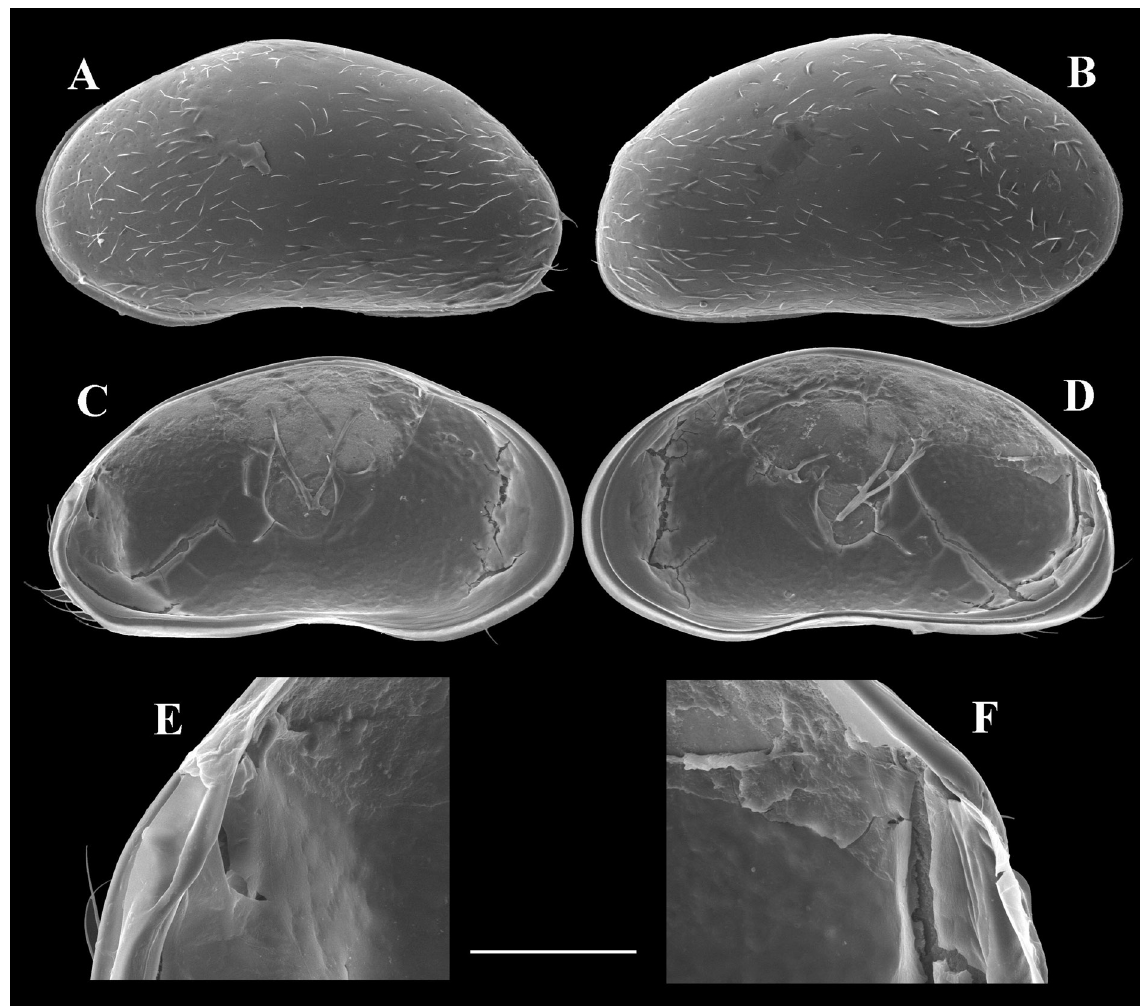
Fig. 8. Siamopsis conspecta gen. et sp. nov., ♀ (MSU-ZOC.201). A . LVe. B . RVe (idem). C . LVi (idem). D . RVi (idem). E . Postero-dorsal part of LVi (idem). F . Postero-dorsal part of RVi (idem). Scale bar: A–D = 200 μ m; E–F = 56 μ